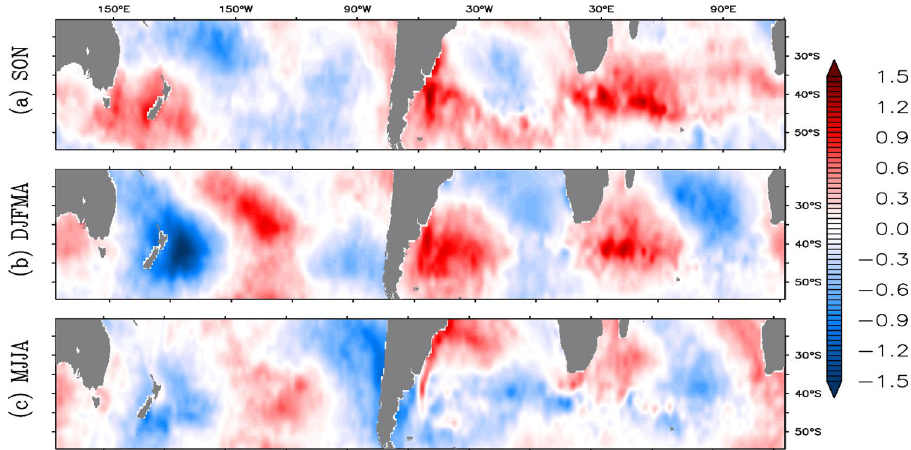
Figure 5. Second spatial mode of the seasonal EOFs (standardized by their respective standard deviations in PCA’s) using SST anomaly over the region (20°S–55°S) from HadISST.